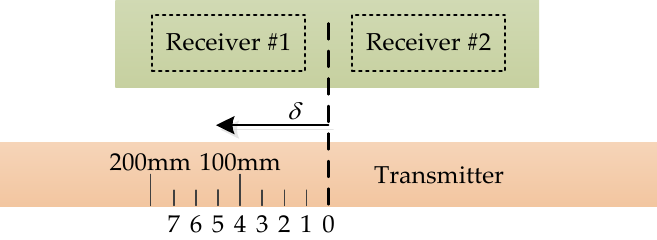
Figure 12. Diagrammatic sketch of the track and trolley.